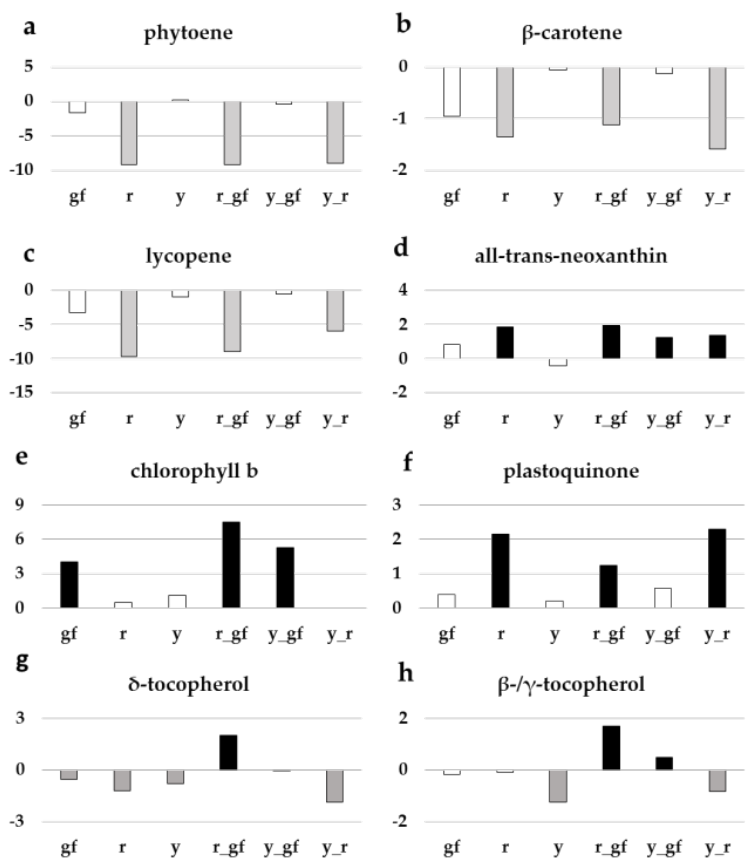
Figure 5. Relative log2 variation in ( a ) phytoene, ( b ) β -carotene, ( c ) lycopene, ( d ) all-trans-neoxanthin, ( e ) chlorophyll b, ( f ) plastoquinone, ( g ) δ -tocopherol, ( h ) β - / γ -tocopherol, of six fruit mutant lines in San Marzano (SM) background compared with the recurrent parent. Line symbols are reported in Table 1. Bars colored in grey and black indicate means significantly lower and higher than SM for p ≤ 0.05 after Student’s t -test,